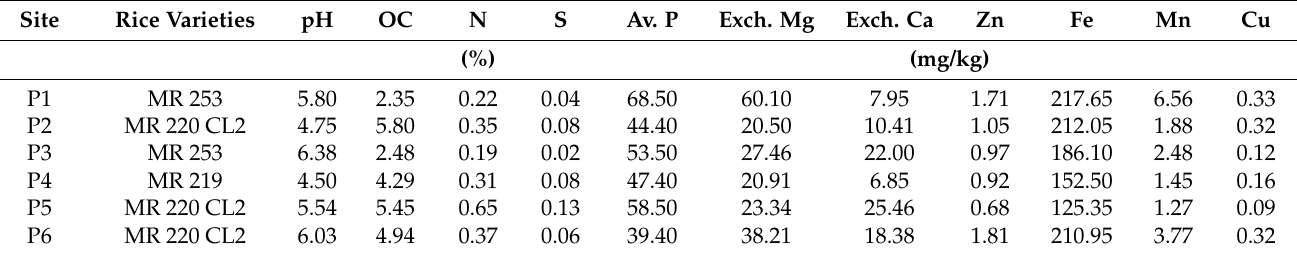
Table 3. Chemical properties of the sampling sites in the wetland fields of Selangor, Malaysia.